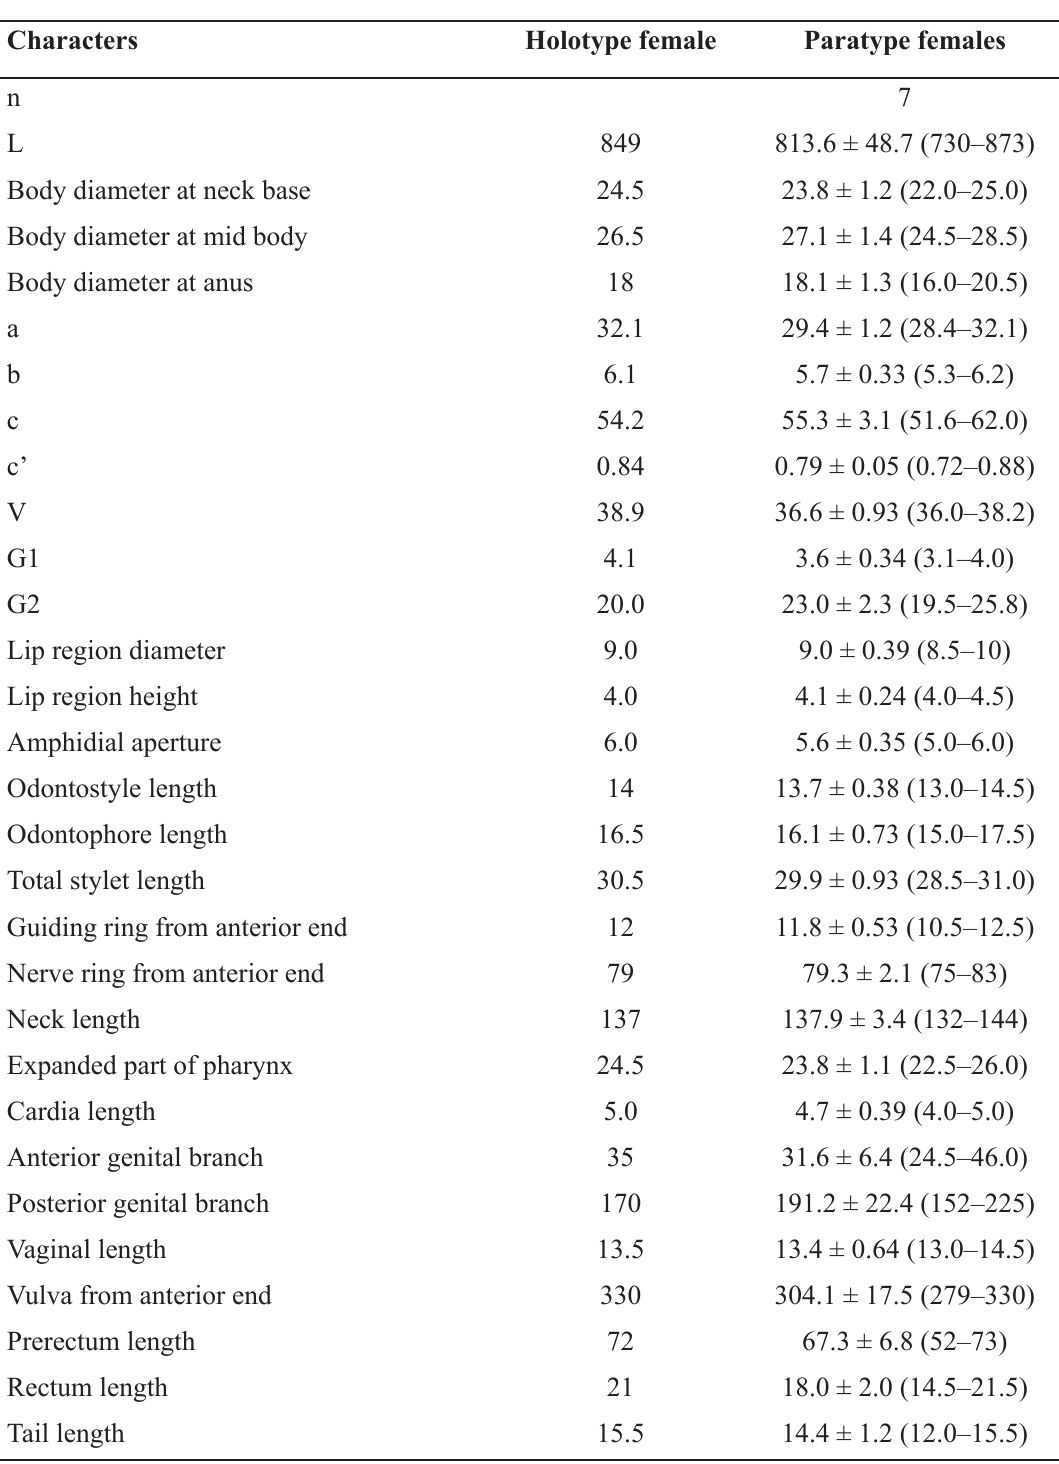
Table 9. Measurements of Basirotyleptus goaensis sp. nov. All measurements are in μm and in the form: mean ± s.d.